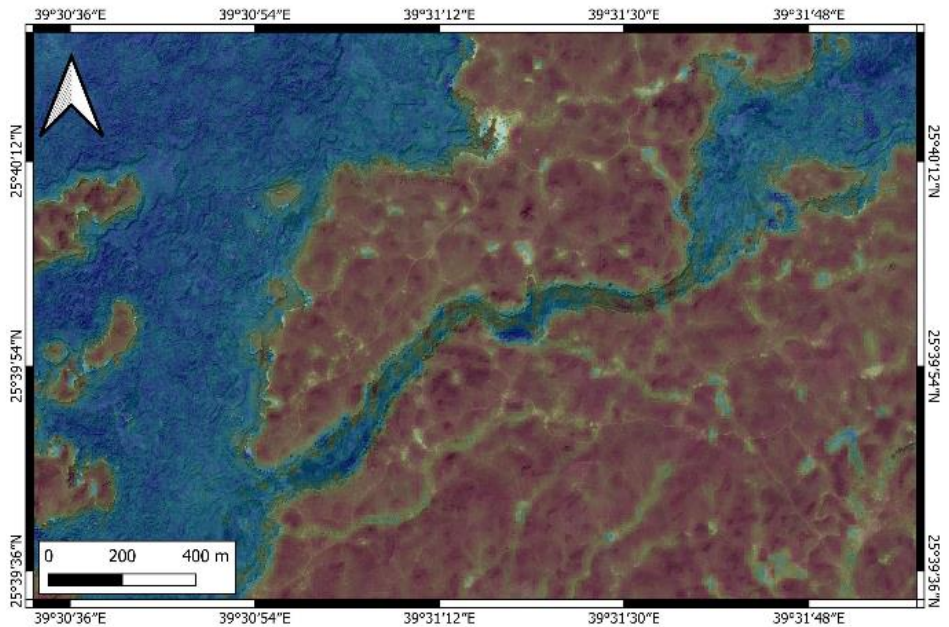
Figure 23. Narrow lava-tube-filled flow zone at mid-distance from the source of the lava on a Sentinel moisture index map. Note the less moist zones of the narrow lava flow, indicating some breakage of the lava crust and developing rubbly p¯ahoehoe that is reconnecting downflow with the main flow zone. Flow direction is from top to bo tt om.